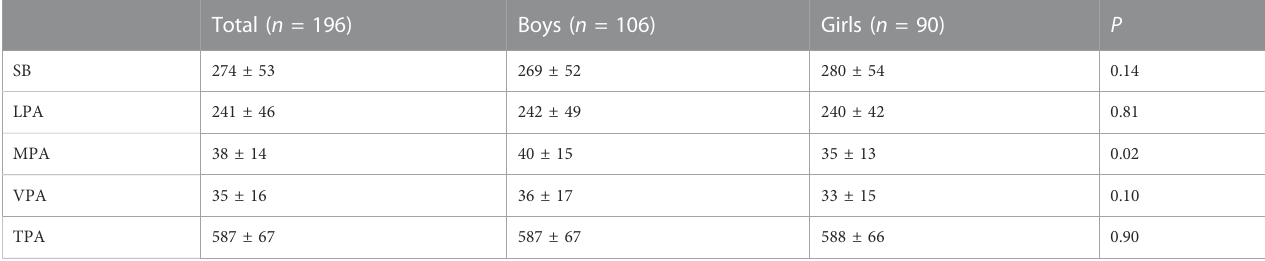
TABLE 2 Participants ’ average daily physical activity of different intensities.